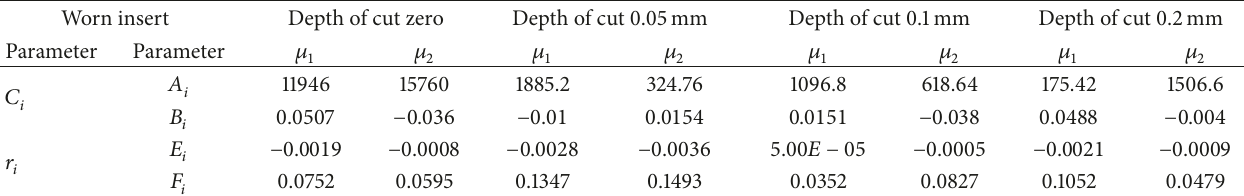
Table 4: Values of the parameter’s constants of the friction coefficient functions, in the case of the worn insert. Worn insert